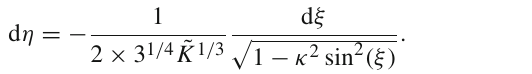
Here, we introduce the normalized K -number 1 defined as ˜ )/( 3 π M 2 ) K . Integrating the previous K := ( 2 ¯ h 2 H 2 dS P